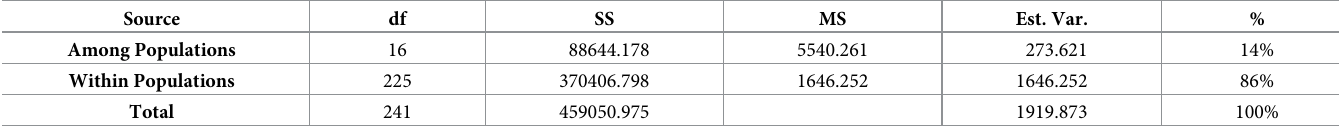
Table 4. Analysis of Molecular Variance (AMOVA) within/among Cynara cardunculus populations. Source df